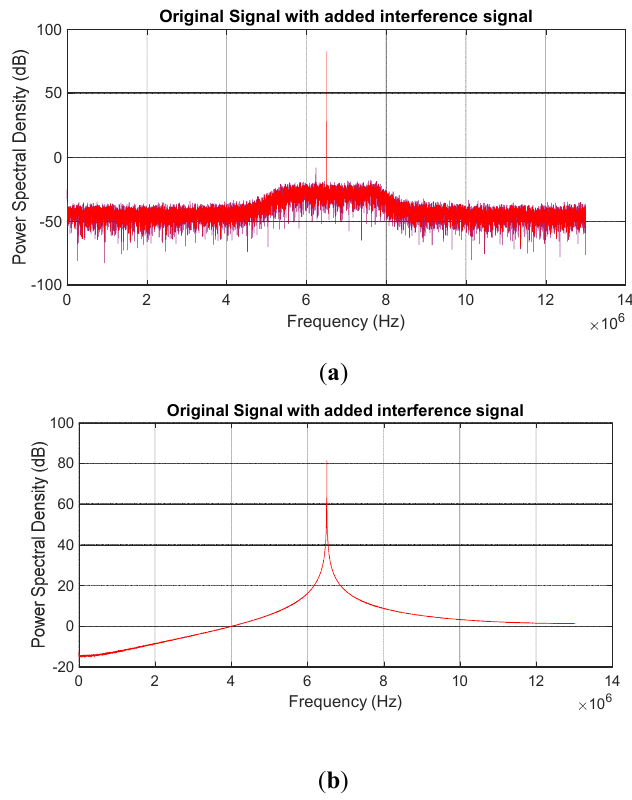
Figure 7. Frequency spectrum estimated by a 1024-point FFT of the sampled RF front-end data with ( a ) 6.5 MHz interference at ( J / No ) = 110 dB-Hz. ( b ) 6.5033 MHz interference at ( J / No ) = 110 dB-Hz.